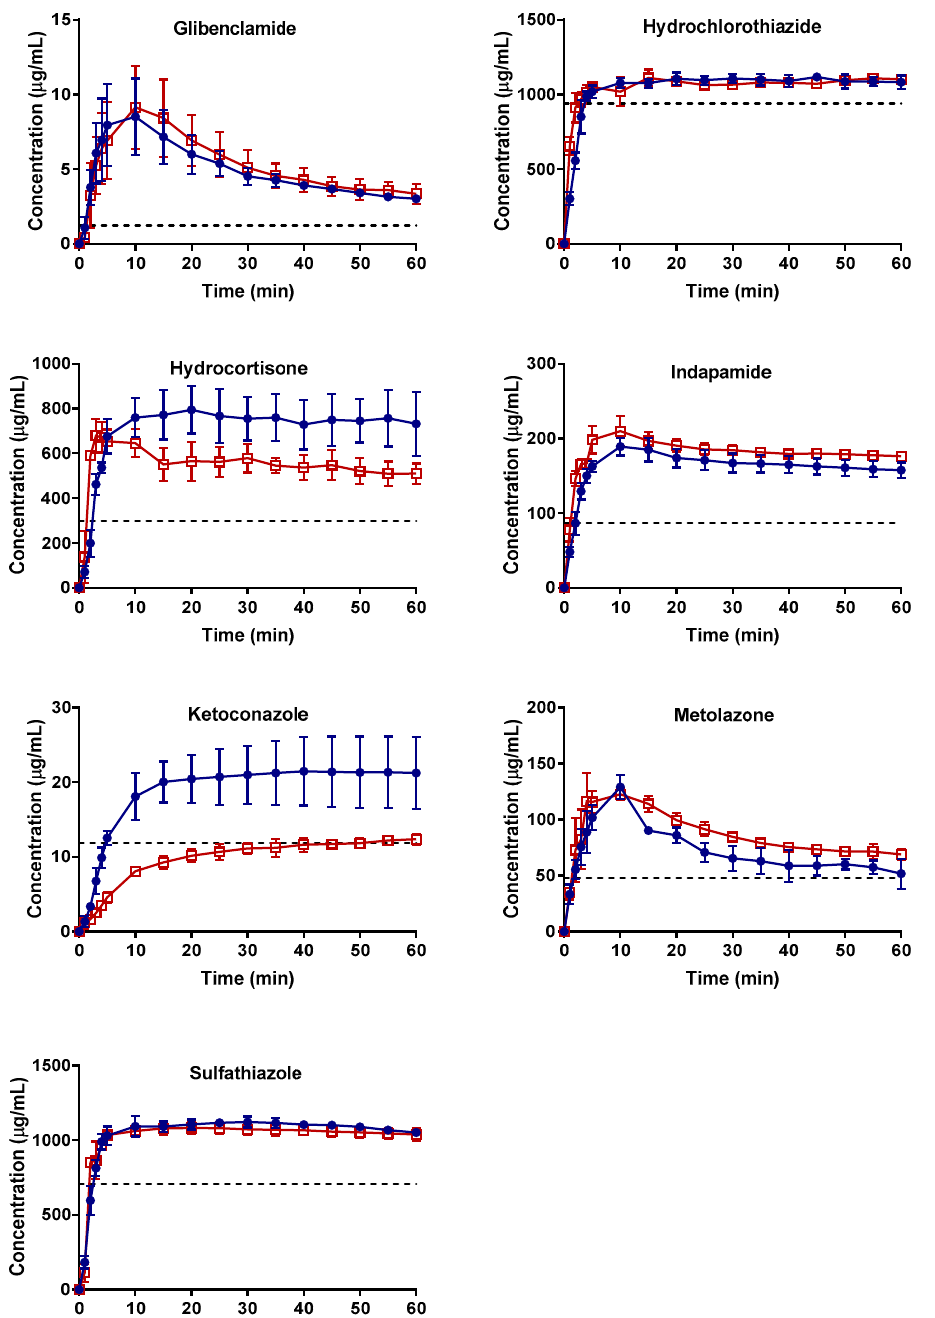
Figure 1. Concentration–time profiles of freshly spray-dried APIs (SD T 0 ) shown as blue circles. The crystallized and / or aged spray-dried APIs (SD T n ) are shown as red empty squares. The time point n depends on (i) the time point at which the spray-dried samples completely crystallized or (ii) the last time point of the stability study (i.e., 168 days) if crystallization was incomplete or did not happen (as indicated in Table 1). The apparent crystalline solubility of each API is shown as a black dashed line. The mean ± standard deviation values of three replicates are shown.